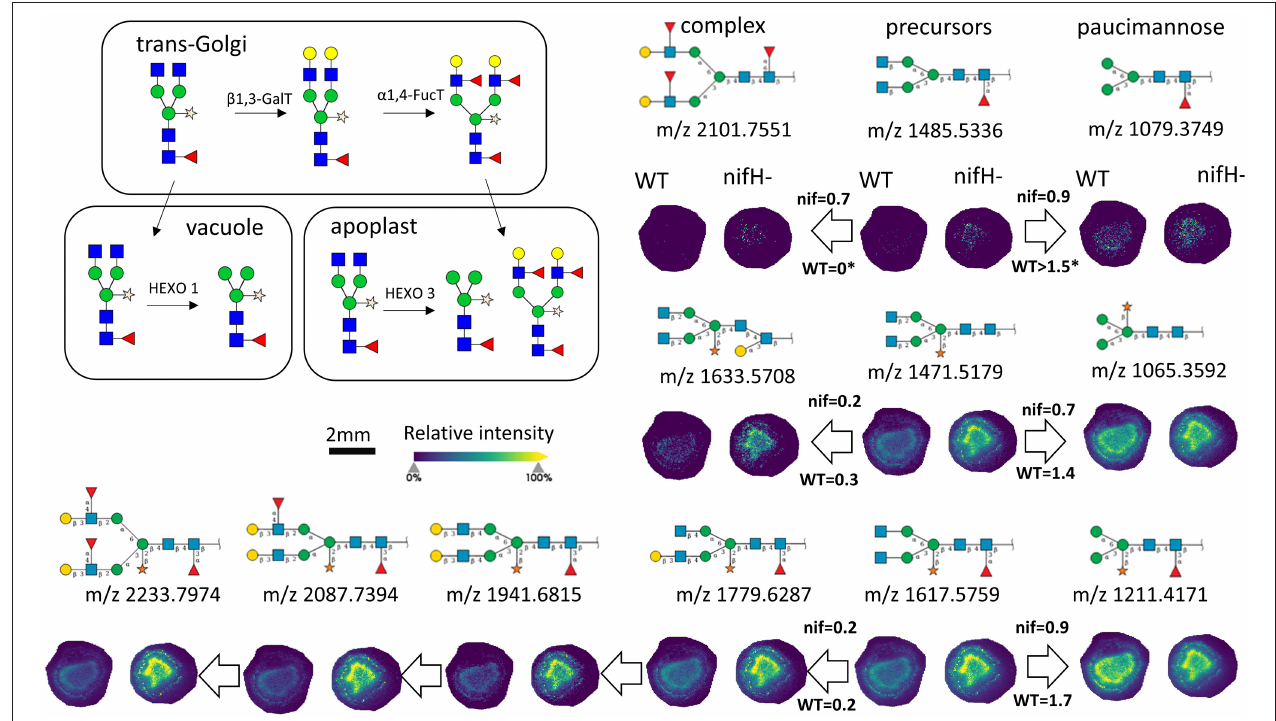
FIGURE 3 | Late stages of N -glycan maturation: Lewis-a epitope decoration in trans-Golgi and truncation of N -glycans in vacuole and apoplast to paucimannose structures (adapted from Bosch et al., 2013), and ion images of corresponding N -glycans involved in the late stages of maturation are illustrated. On the arrows are displayed intensity ratio between the corresponding N -glycan signal pairs (ea. paucimannose/precursor and complex/precursor) in the WT and nifH- nodules, showing that truncation reaction is more intense in WT nodules. For each N- glycan ion image, a color scale bar was created